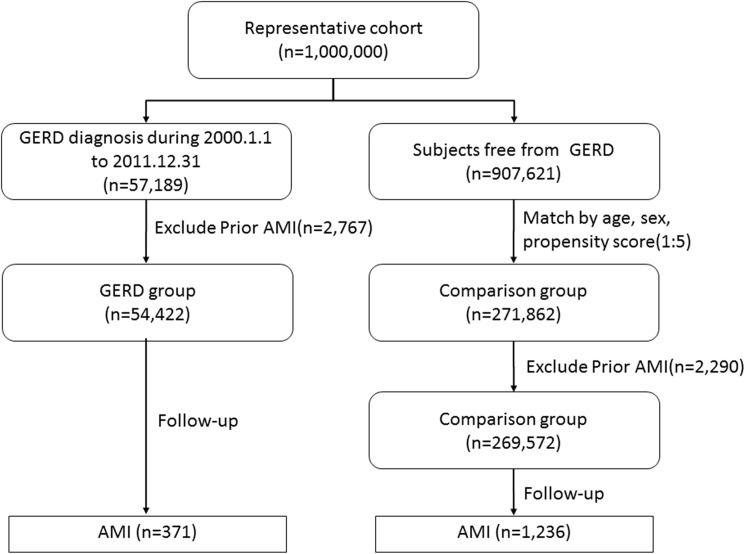
Flowchart of subjects enrolled into the study.